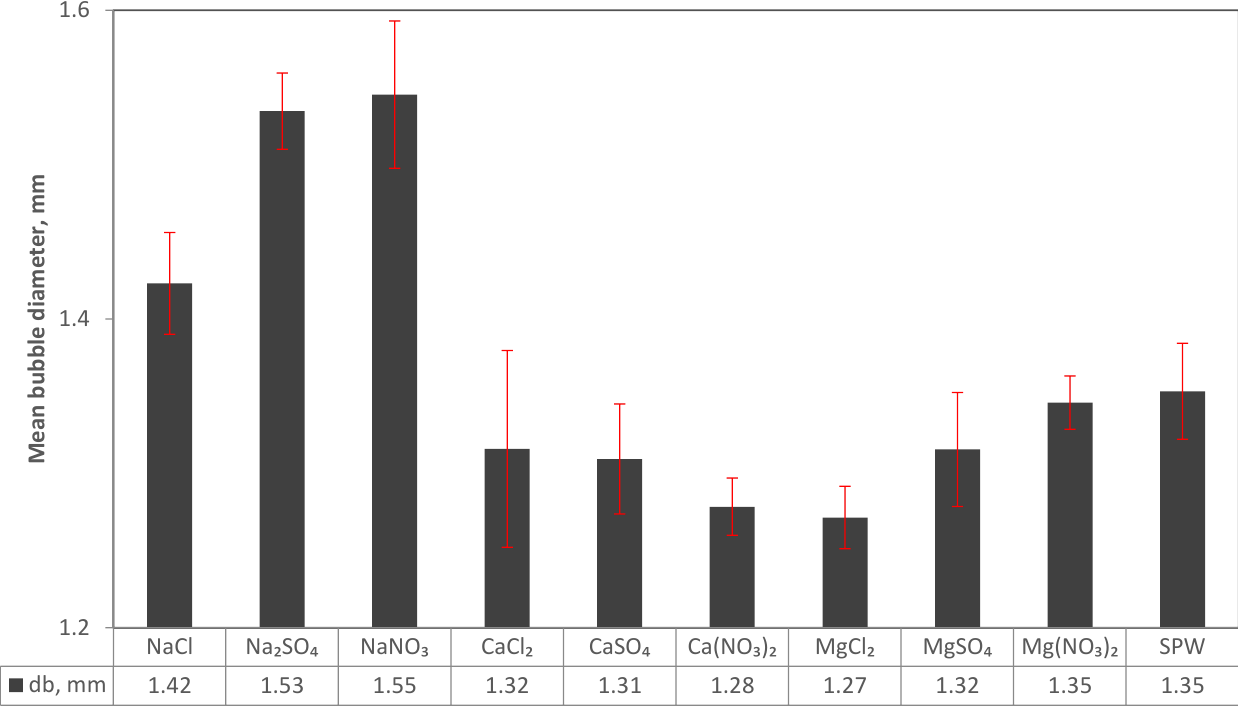
Figure 6. Specific ion effects on the mean bubble diameter.